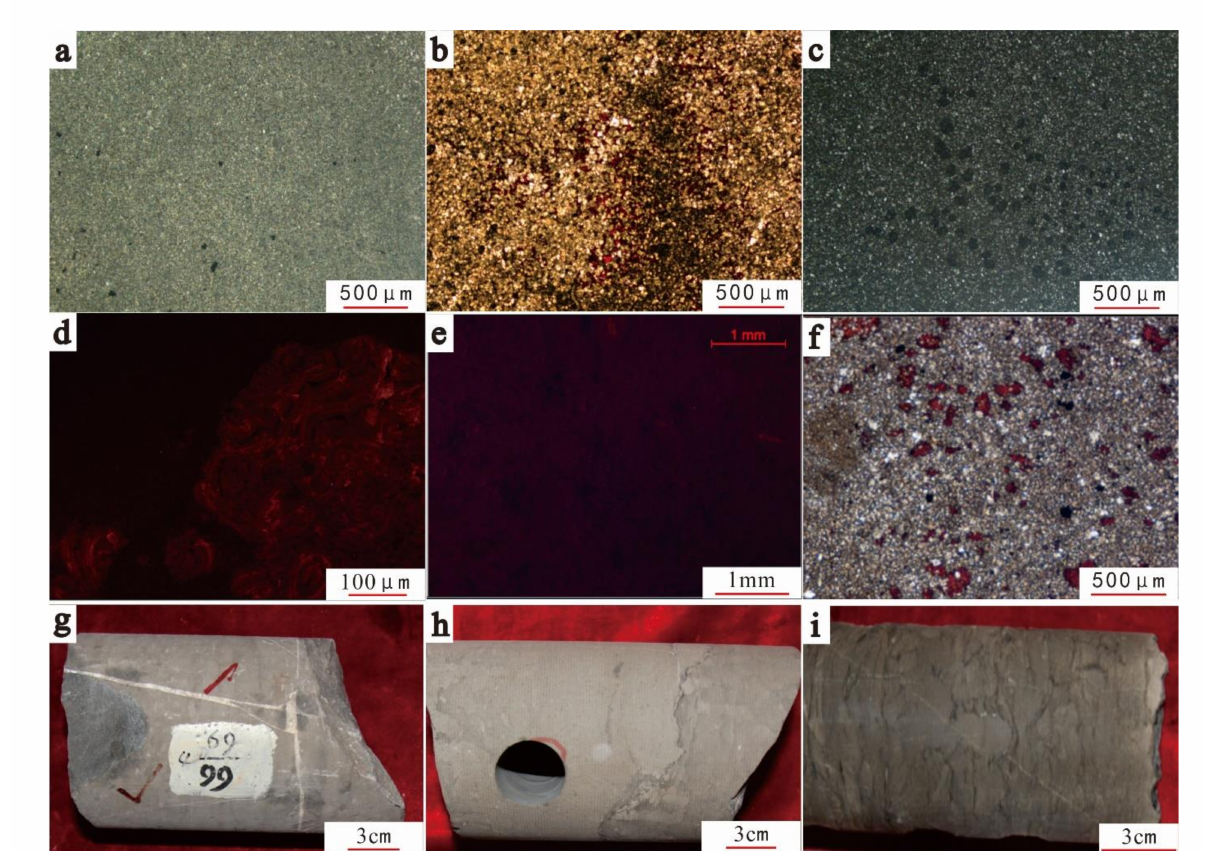
Figure 3. Microscopic characteristics and core observations of carbonate rocks in M 55 of the Daniudi Gas Field, Ordos Basin. ( a ) D37, 2926.91, m—microcrystalline dolostone; ( b ) D1-530, 3107.28, m—very fine crystalline dolostone; ( c ) D48, 3024.95, m—microcrystalline limestone; ( d ) PG27, 2979.52, m—calcite cement characteristics under CL; ( e ) D48, 3023.54, m—dolomite characteristics under CL; ( f ) D48, 3013, m—tuberculosis of anhydrite are replaced by calcite; ( g ) D48, 3020.48,